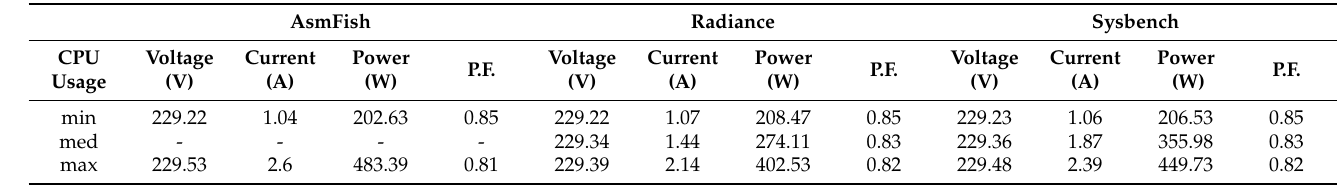
Table 4. Server rack measurements using Phoronix benchmarks as